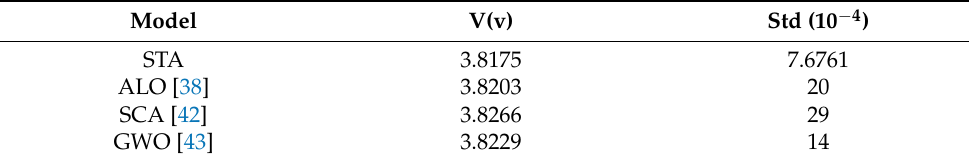
Figure 9. Comparison of the results of STA, ALO, SCA, and GWO optimization. Table 5. Comparison of the results of STA, ALO, SCA, and GWO